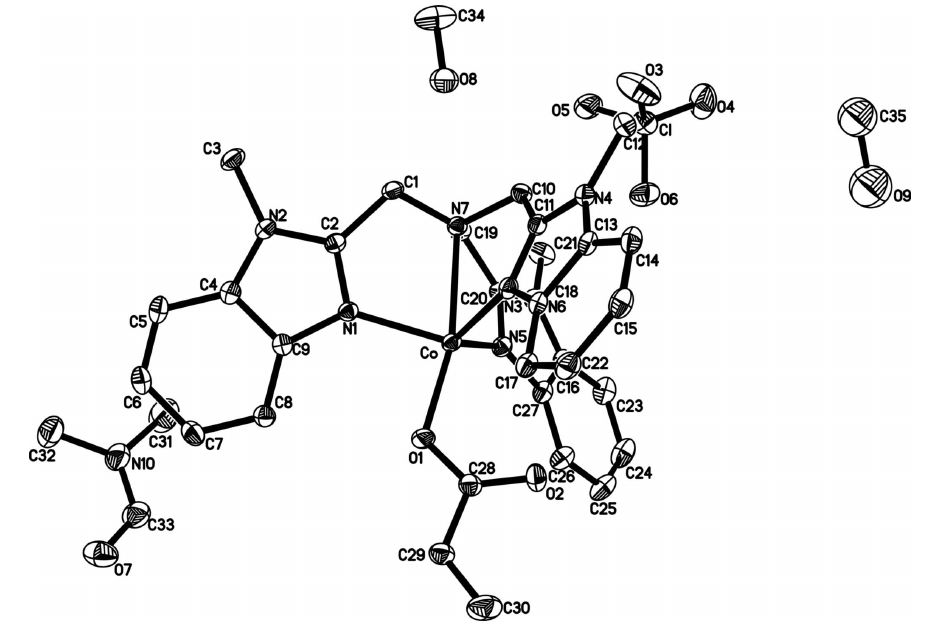
Figure 1 Molecular structure and atom numbering for the components of (I). Hydrogen atoms have been omitted for clarity and the displacement ellipsoids are shown at the 30% probability